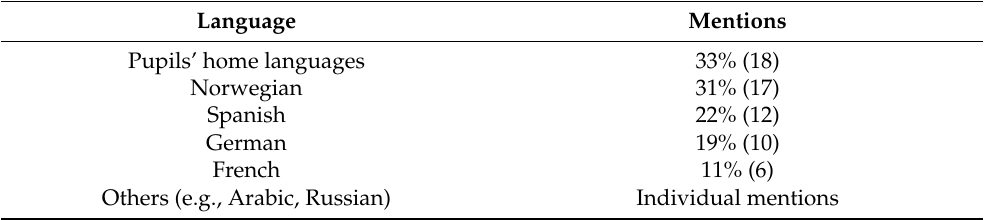
Table 11. Other languages participants would include in the EFL classroom. Mentions are given as a percentage of the total number of participants, followed by the absolute number of mentions. More than one language can be present in a single participant’s answer.